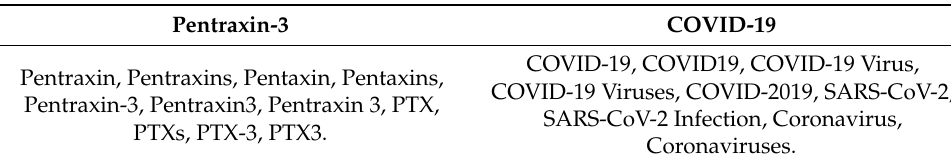
Table 2. Keyword combinations used during the search